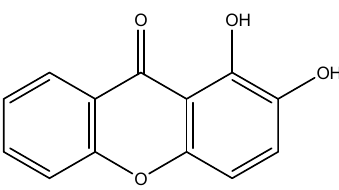
Figure 1. Structure of 1,2-dihydroxyxanthone (1,2-DHX).